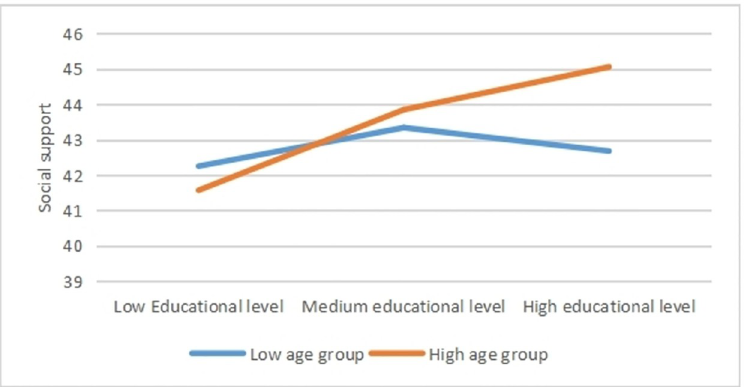
Fig 4. Moderating effect. Social support as a function of educational level and age. Functions are graphed for two levels of age. Note that this graph is only for descriptive